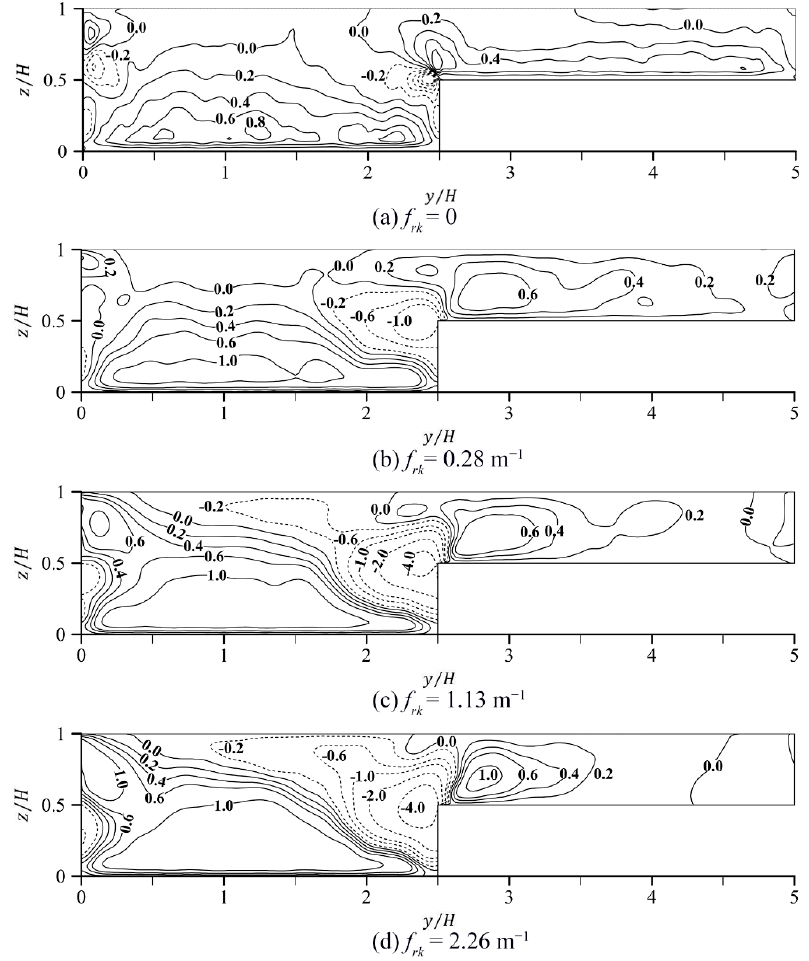
′ ′− 2 u w u Figure 10. Reynolds stress −(cid:104) u (cid:48) w (cid:48) (cid:105) / u 2 τ with different floodplain vegetation densities. ( a ) Case with Figure 10. Reynolds stress with different floodplain vegetation densities. (a) Case with τ f rk = 0. ( b ) Case with f rk = 0.28 m − 1 . ( c ) Case with f rk = 1.13 m − 1 . ( d ) Case with f rk = 2.26 m − 1 f rk =0. (b) Case with f rk =0.28m − 1 . (c) Case with f rk =1.13m − 1 . (d) Case with f rk =2.26m − 1 .